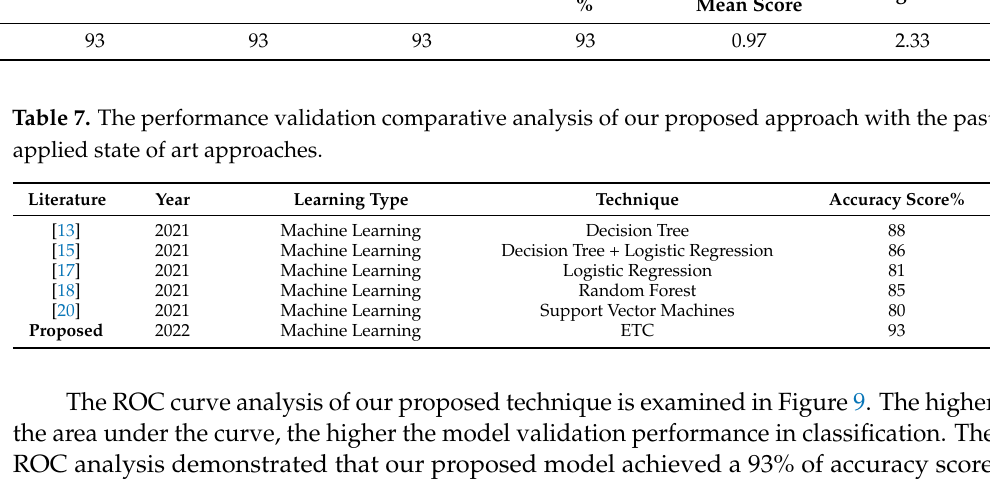
Table 7. The performance validation comparative analysis of our proposed approach with the past applied state of art approaches.